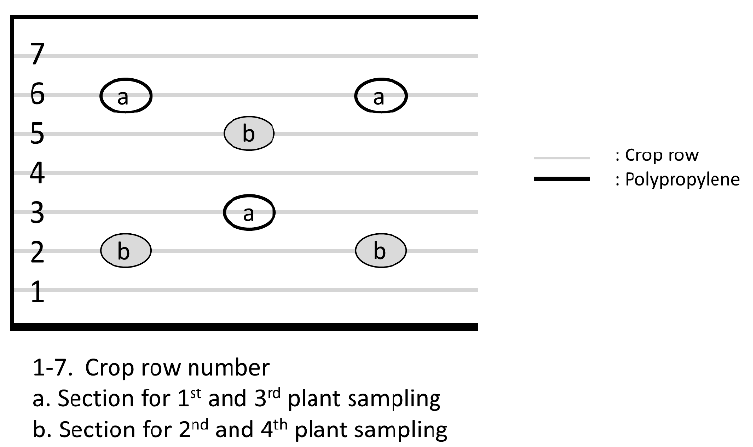
Figure 3. Schematic diagram of plant sampling setup for an experimental plot.